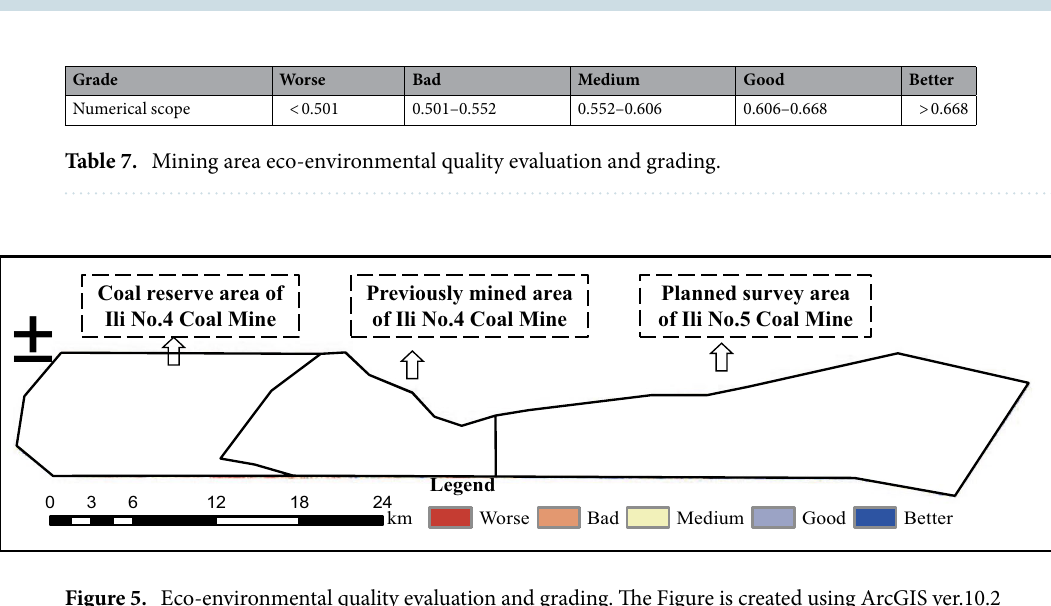
Figure 5. Eco-environmental quality evaluation and grading. The Figure is created using ArcGIS ver.10.2 (https:// www. esri. com/).